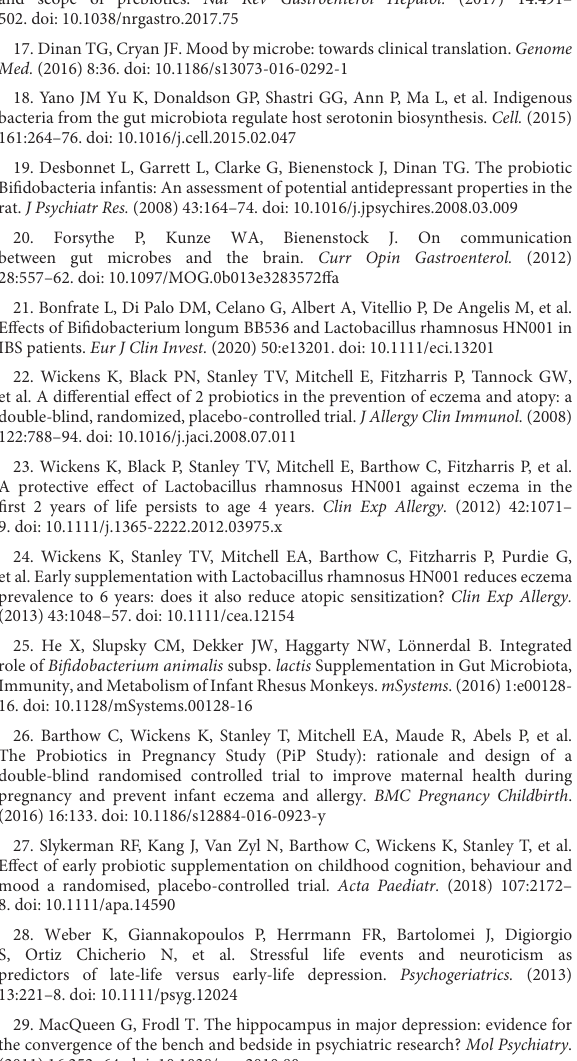
SUPPLEMENTARYFIGURE2 Effects of probiotics treatment on Beta-diversity induced by CUMS. (A) Number of weight Beta-diversity estimates of microbiota. (B) The results of ANOSIM analysis based on Bray-Curtis